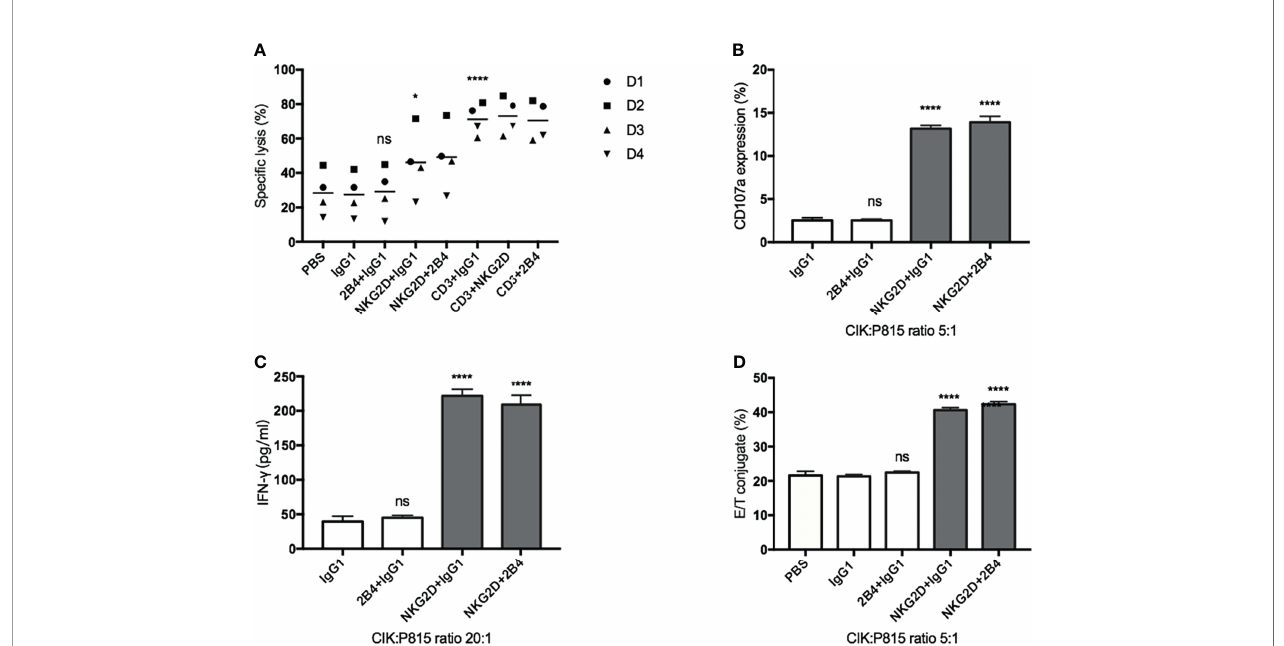
FIGURE 3 | NKG2D (not 2B4) increases the CIK cell-mediated cytotoxicity, degranulation, IFN- g secretion, and E/T binding against P815 cells. (A) . CFSE-labeled P815 cells were preincubated with indicated antibodies at a concentration of 5 µg/ml (except anti-CD3, 0.05 µg/ml) for 30 min before coculture with CIK cells. After 6 – 8 h of coculture at a 20:1 E/T ratio, cells were stained with Hoechst 33258 and measured on fl ow cytometry. (B) P815 cells were preincubated with indicated antibodies (5 µg/ml) for 30 min before coculture with CIK cells. After 5-h coincubation at an E/T ratio of 5:1 in the presence of anti-CD107a-APC and GolgiStop, the percentage of CD107a in bulk CIK cells was determined by FACS. (C) P815 cells were preincubated with indicated antibodies (5 µg/ml) for 30 min before coculture with CIK cells. After 20-h coincubation at an E/T ratio of 20:1, IFN- g level in supernatant was determined by sandwich ELISA. (D) Conjugate assay was performed as described in against antibody-loaded P815 cells at an E/T ratio of 5:1. The data are represented as mean ± SD of triplicates per condition and one representative of at least three independent experiments. * p < 0.05, **** p < 0.0001, ns, not signi fi cant, calculated by one-way or two-way ANOVA, Bonferroni ’ s post-hoc